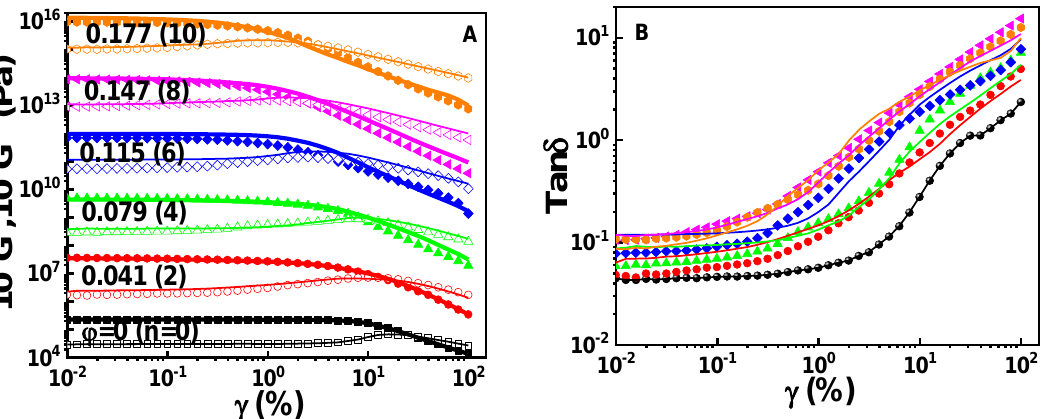
Figure 9. G ’ (solid symbols and thick curves, A ), G ” (hollow symbols and thin curves, A ) and tan δ ( B ) as a function of γ for the gum and filled vulcanizates containing Si69 (curves) or Si69 / [EMIM]OAc (symbols) at 100 ◦ C and 10 rad / s. The data of G ’ and G ” are vertically shifted by a factor of 10 n as indicated.